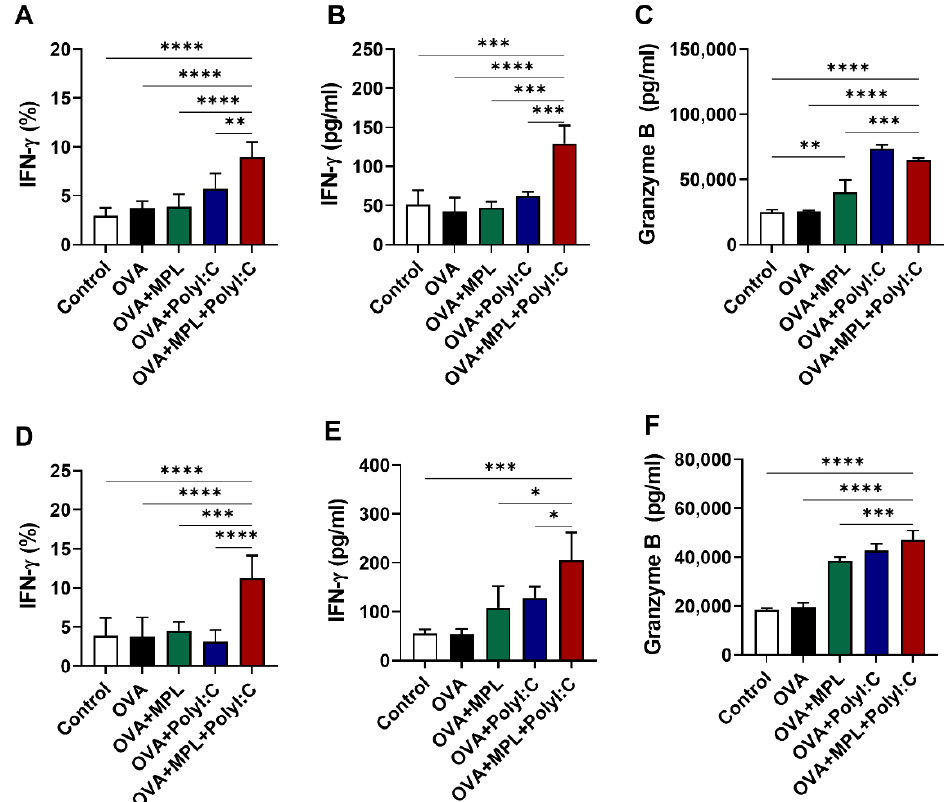
Figure 3. Cytokine production after intranasal immunizations of OVA with adjuvants. Lung samples were collected after one day post prime ( A – C ) and boost ( D – F ) immunizations. ( A , D ) The frequencies of IFN- γ -positive NK cells were analyzed by flow cytometry. ( B , C , E , F ) The concentration of IFN- γ and Granzyme B in lung homogenates were measured by ELISA. The data show the mean ± SD. Statistical analysis between groups were performed by one-way ANOVA and Tukey’s multiple comparison test. * p < 0.0332, ** p < 0.0021, *** p < 0.0002 and **** p <